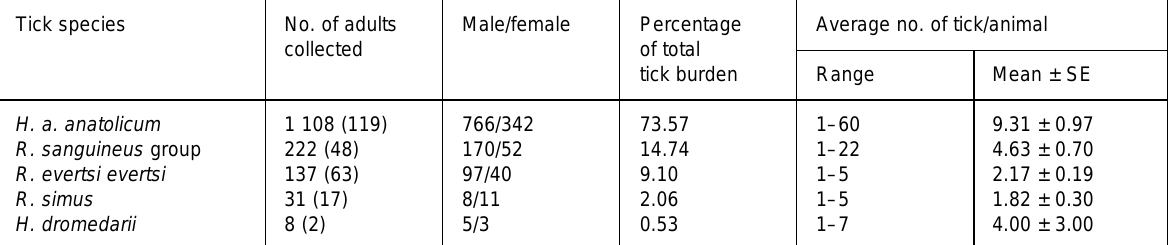
TABLE 1 Prevalence of different tick species infesting sheep in River Nile Province. Figures in parenthesis represent numbers of animals infested Tick species